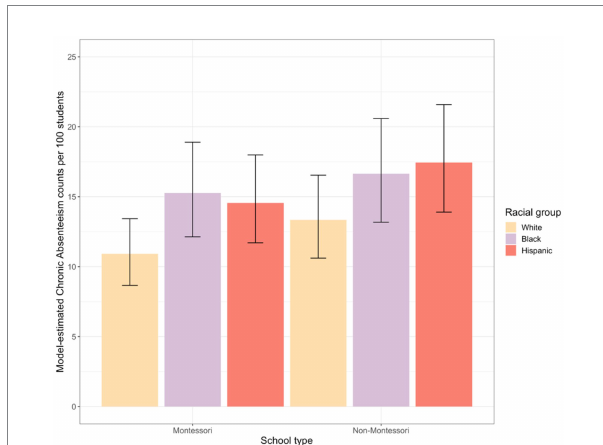
FIGURE 1 Differences in chronic absenteeism between racial groups across Montessori and non-Montessori schools. Errors bars represent bias- corrected 95% bootstrap confidence intervals. Predicted values were generated by setting the charter variable equal to 1, the magnet variable equal to 0, and continuous covariates equal to their means (in the non-bootstrapped data): 26.44 for percent Black students, 22.51 for percent Hispanic students, 40.22 for percent White students, 12.04 for percent IDEA, and 51.84 for percent